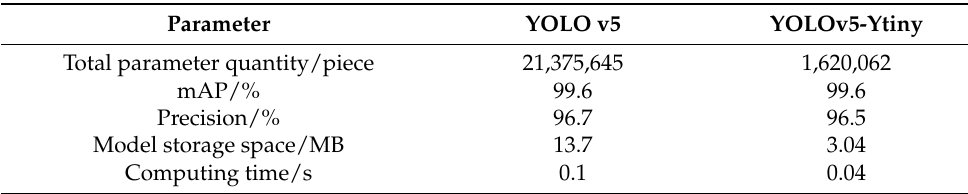
Table 2. Improved model